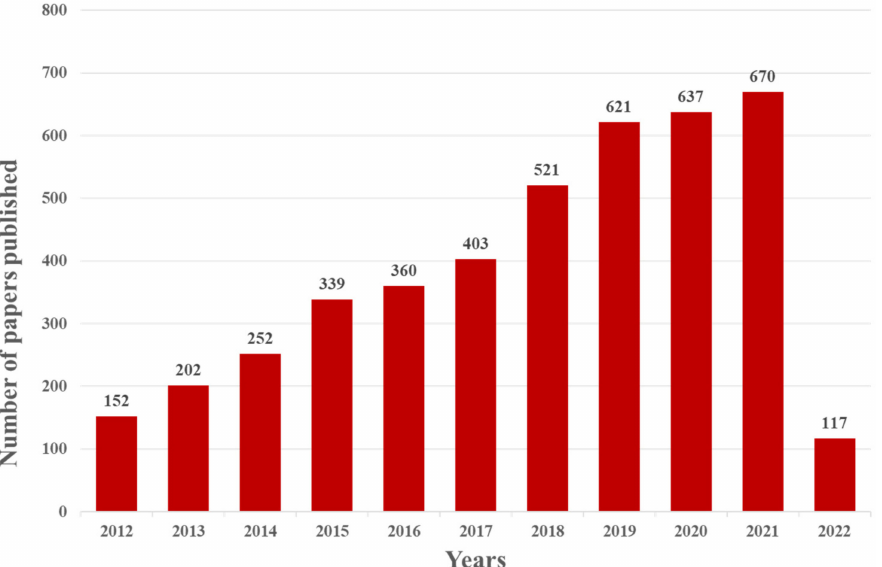
Figure 2. Web of Science report for the number of indexed papers and patents about the application